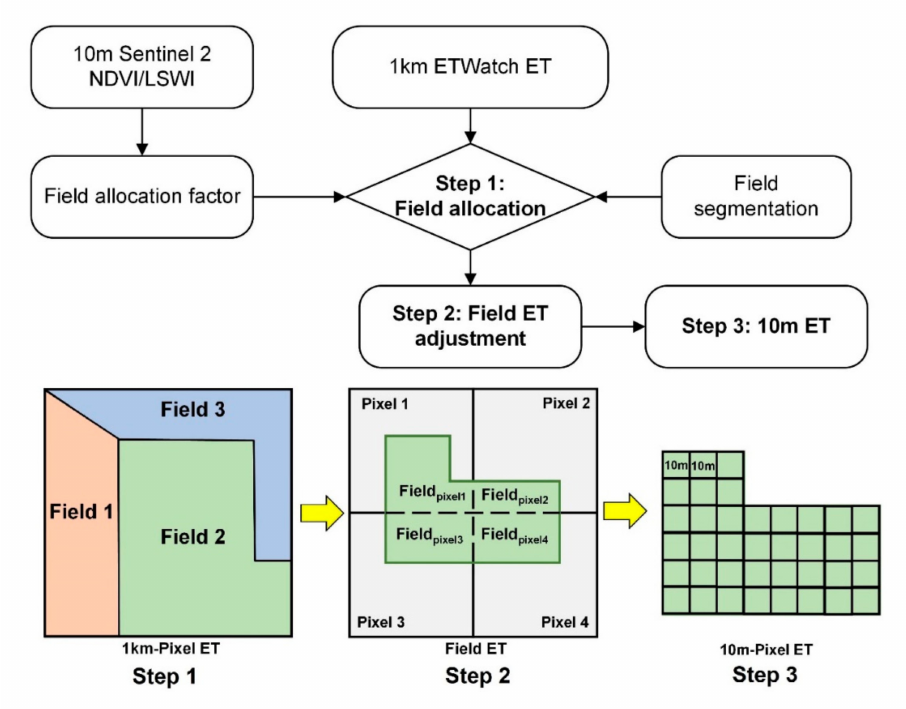
Figure 1. Flowchart of the evapotranspiration (ET) allocation method. The upper figure is the calculation algorithm, and the below figure is the three steps of field ET allocation from 1-km pixel ET to 10-m pixel ET. NDVI: normalized difference vegetation index and LSWI: land surface water